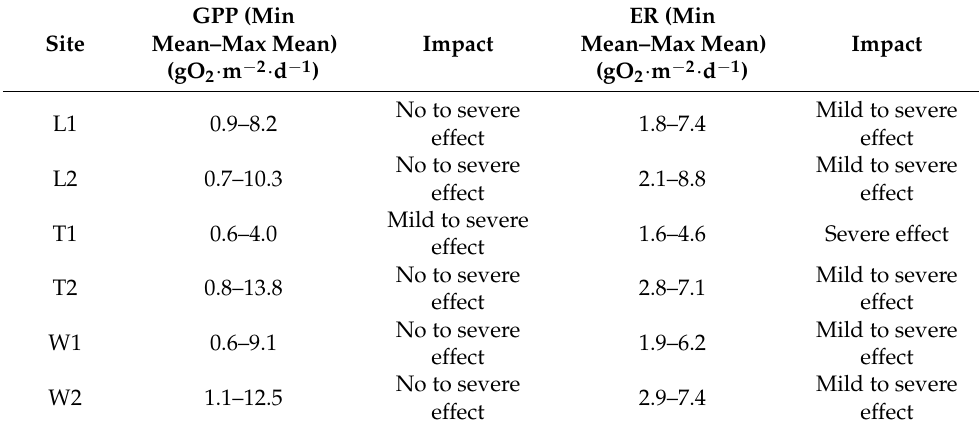
Table 3. Mean and seasonal range of GPP and ER (both were multiplied by water depth) across the study sites during the study period. The minimum and maximum GPP appeared in winter and summer, respectively. The minimum and maximum ER appeared in winter and autumn (or summer at W1), respectively. Impacts relate to the degree of impaired ecosystem